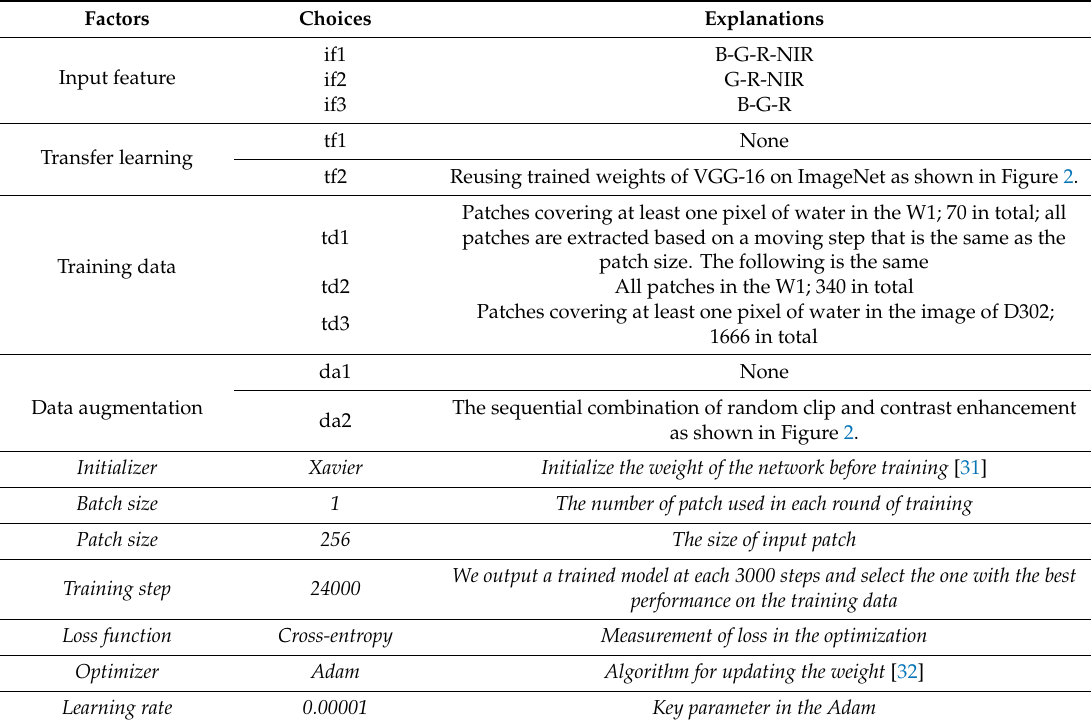
Table 1. Key factors in the model training; we only evaluate factors with multiple choices. Factors